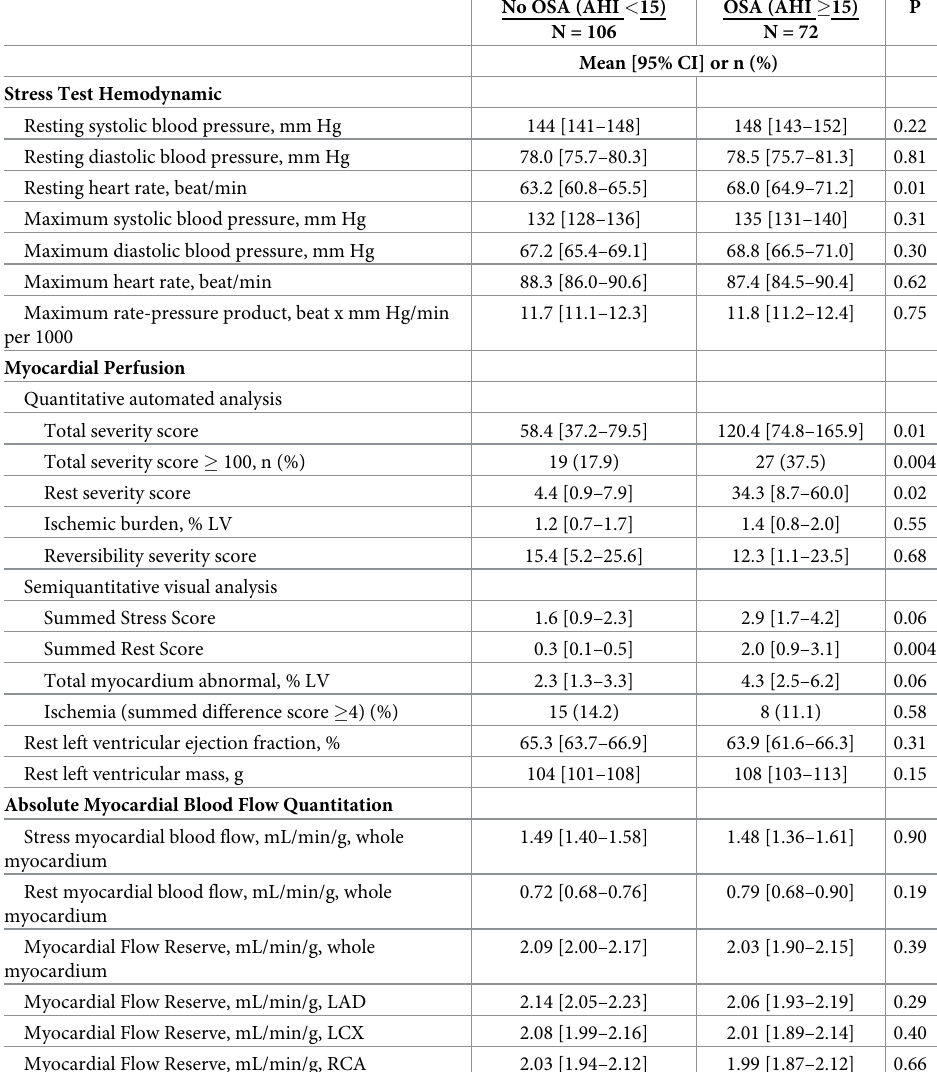
Table 2. Myocardial perfusion imaging data in twins with and without obstructive sleep